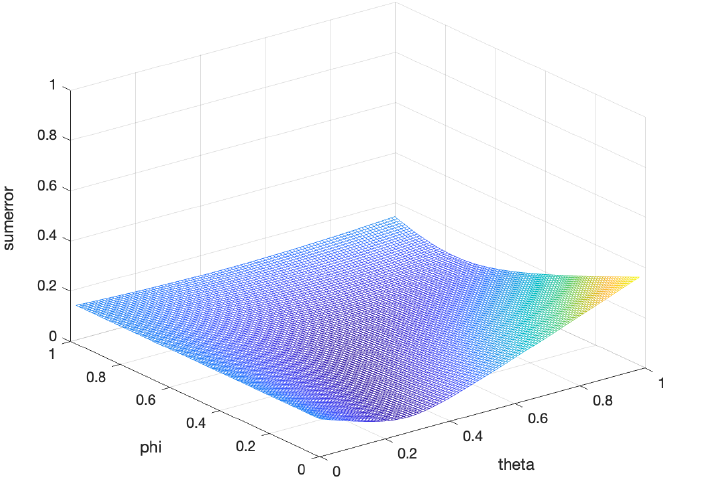
Figure 1. The sum of the error of five-fold cross-validation between the proposed estimation and the population covariance matrix under the different θ and φ for N = 100.